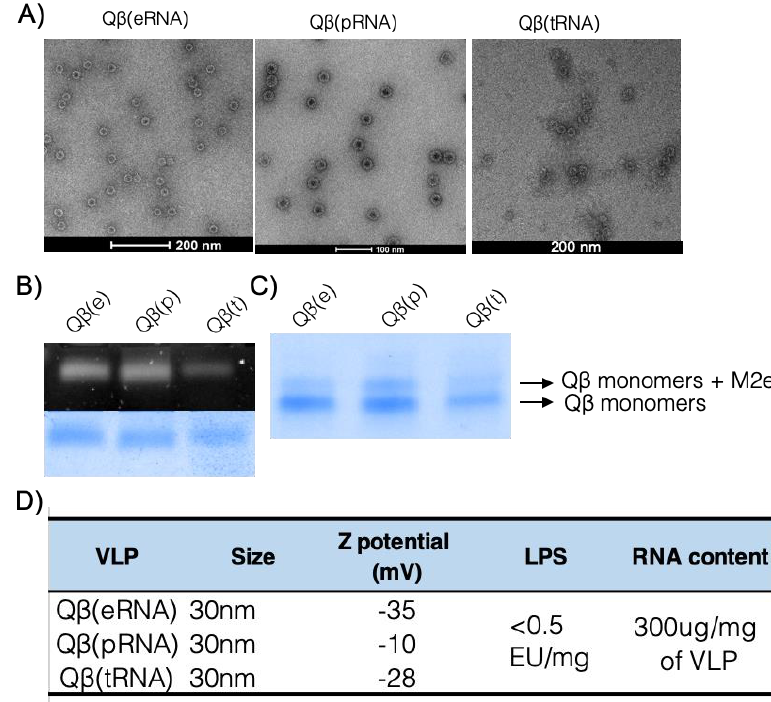
Figure 1. Vaccine preparation and characterisation. ( A ) Electron micrograph of re-assembled VLPs. Q β VLP containing eukaryotic RNA (eRNA), prokaryotic RNA (pRNA) and tRNA (tRNA) have similar structure and size. ( B ) Native analysis of RNA and protein content of re-assembled VLPs. Upper panel showing SYBR staining and bottom panel showing protein staining of same agarose gel. ( C ) Similar coupling e ffi ciency of di ff erent VLPs and M2 peptides on a reduced SDS-PAGE gel electrophoresis. ( D ) Characterisation of VLPs. Size was taken as an average of values obtained in the EM images. Z potential was measured by DLS and is expressed as mV. LPS content expressed on endotoxin units (EU) per milligram of VLP. Average RNA content per mg of VLP. Results are representative of more than 5 independent purification and re-assembly studies.